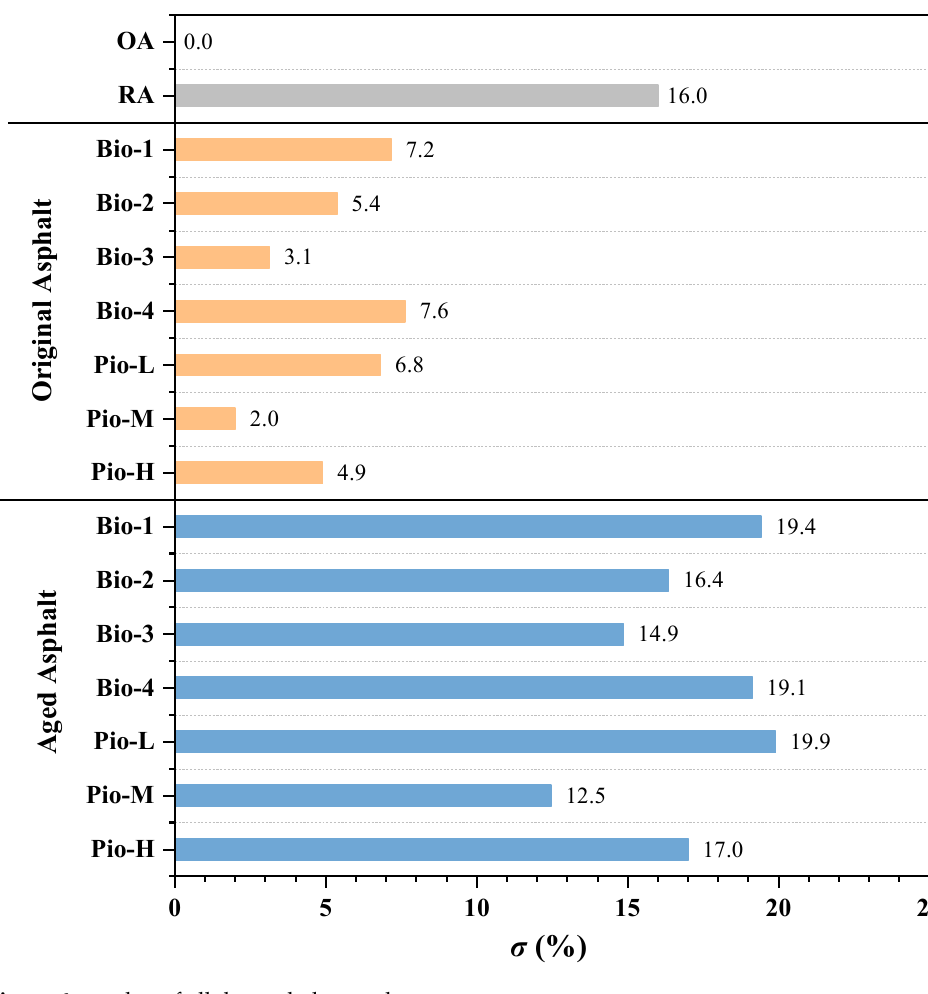
Table 3. Classical BBR test results of all the asphalt